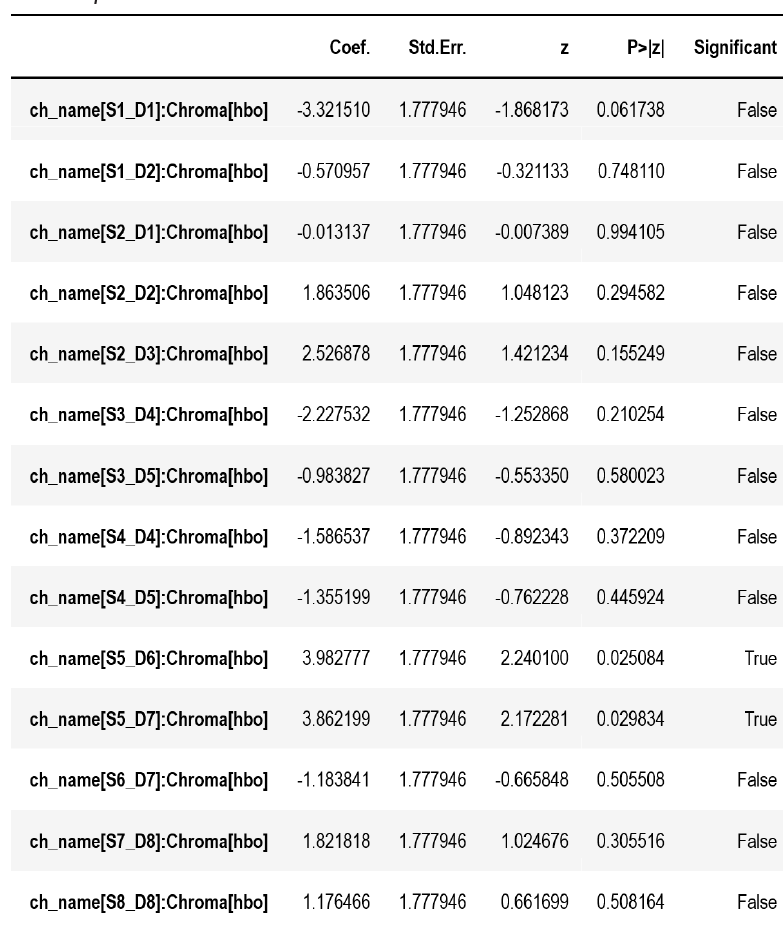
Beta coefficients of second level of GLM contrast “reading task versus a numerical format of calculation” in low level